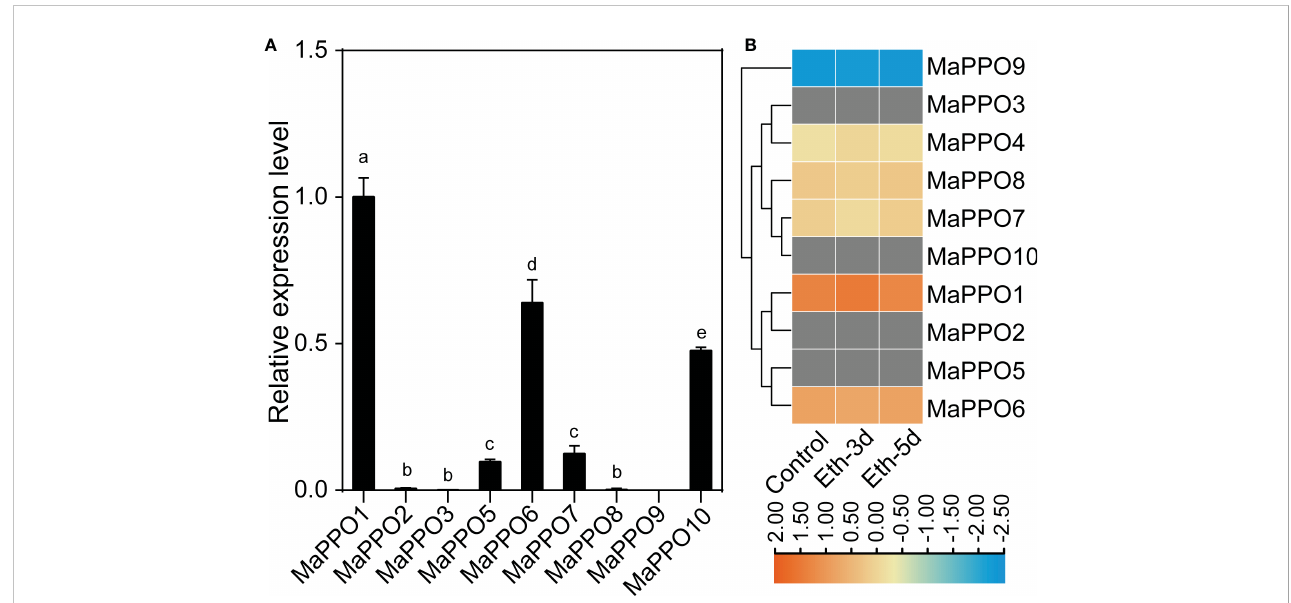
FIGURE 4 Comparison of expression levels of polyphenol oxidase in fruit. (A) qRT-PCR analysis of the expression level of MaPPOs in mature green fruit. (B) Expression level of MaPPO proteins in response to ethephon. The heatmap was generated using proteome data. The color bar indicates the range of maximum and minimum values of relative expression in the heatmap. The gray color indicates that the protein is undetectable. Different letters indicate signi fi cant differences (P < 0.05) examined by one-way ANOVA.